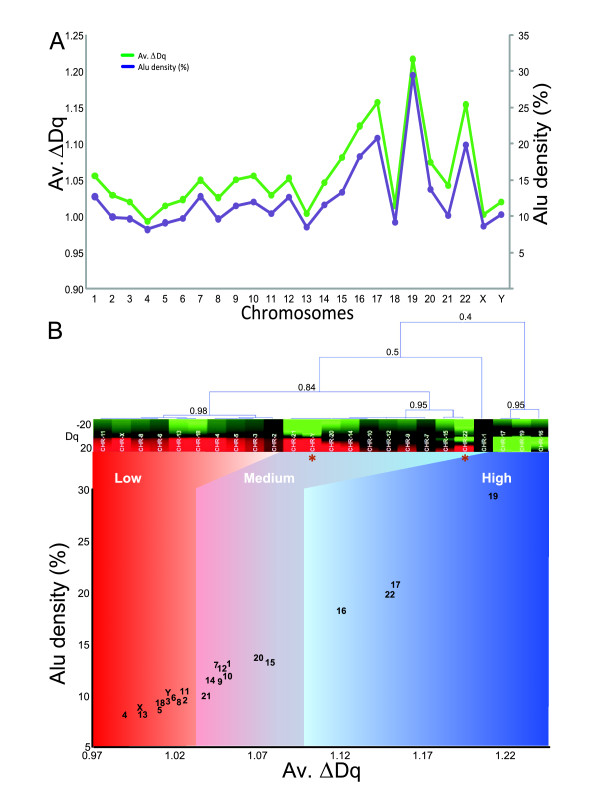
Multifractal classification for the human chromosomes: A: Distributions of the average degree of multifractality (Av. ΔDq) and Alu content per chromosome. B: Discrimination method based on multifractal formalism in a distribution of two-dimensional points, R2 ~0.967, p < 0.05. On top: hierarchical clustering for the averaged multifractal parameters by chromosome between Dq(-20, 20) (color scale bar is indicated). Minimum similarities are indicated near nodes and the asterisks show the only two exceptions found.